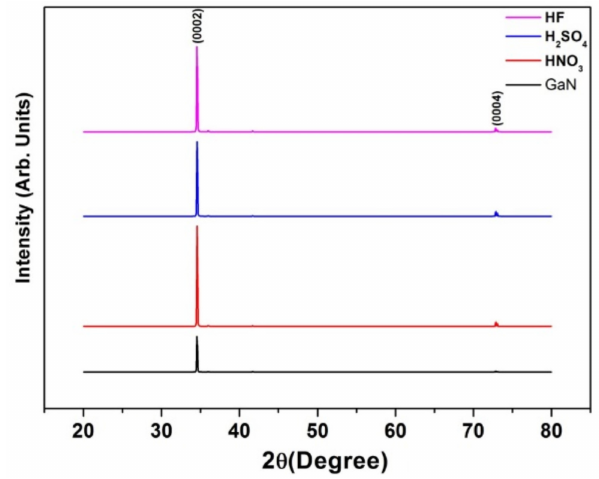
Figure 2. HRXRD patterns of the pristine sample and samples etched with different etchants. Reproduced from [52], with permission from Copyright World Scientific, 2016.